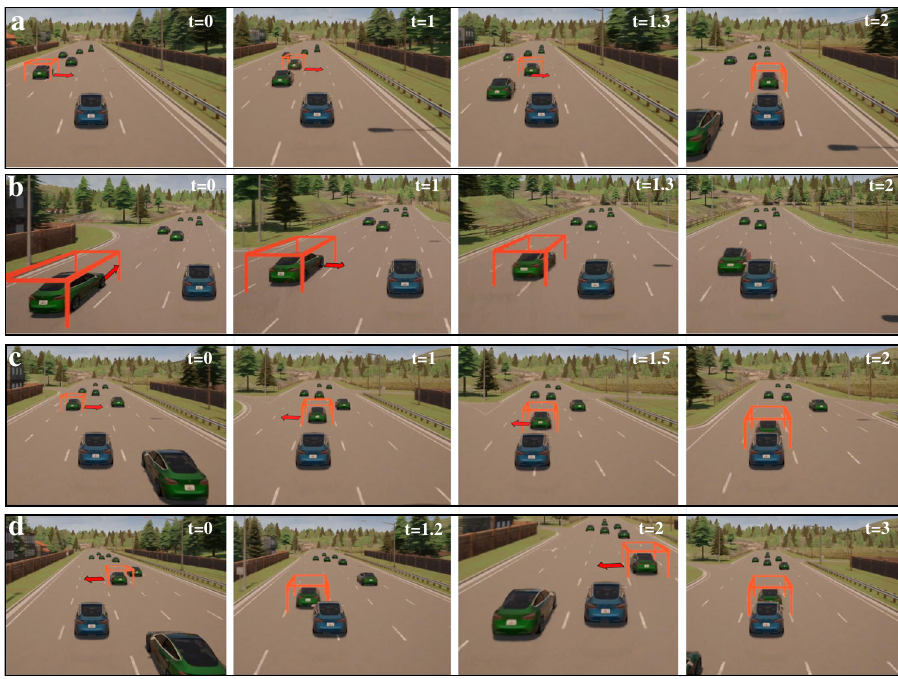
Fig. 8 Adversarial examples generated in NADE. a The autonomous vehicle (AV, blue vehicle) was on high speed and had a rear-end collision with the cut-in principal other vehicle (POV, green vehicle with orange rectangle) after two front-left POVs sequentially changed their lanes towards the AV. b The AV made a left lane change and collided with the POV due to a lane con fl ict (the POV accelerated fi rst and then made a right lane change, simultaneously with the AV). c The AV turned left to avoid the collision to the cut-in POV but failed as the cut-in POV switched back to the left lane simultaneously with the AV. d The AV made an evasive lane change to avoid one cut-in POV but eventually collided with another cut-in